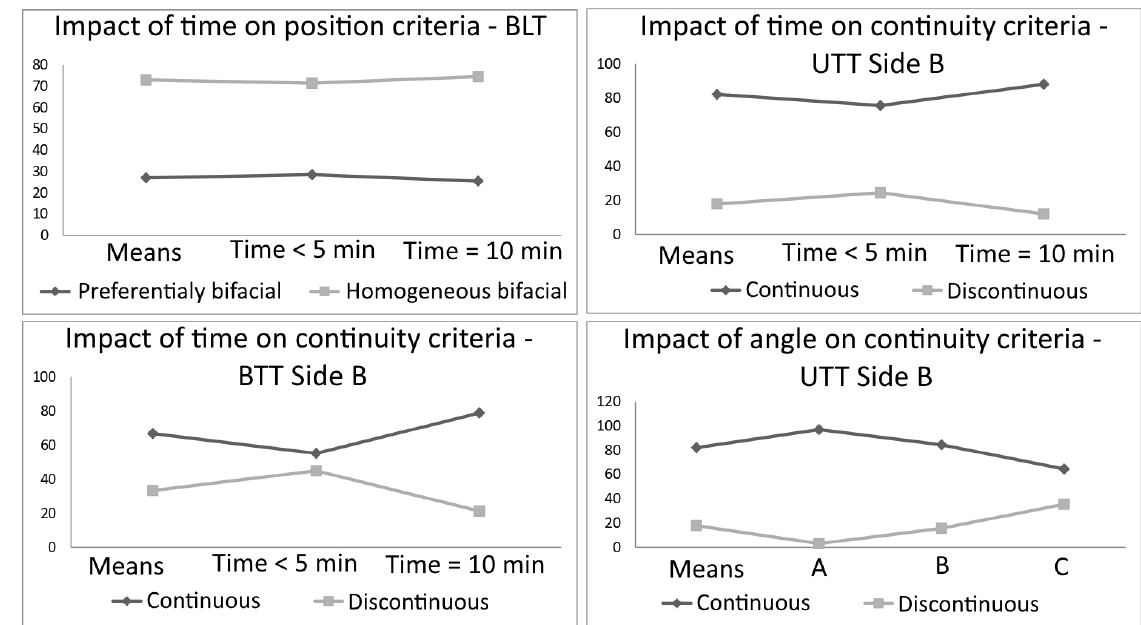
Figure 6. Impact of the duration of use and angle on distribution criteria for different